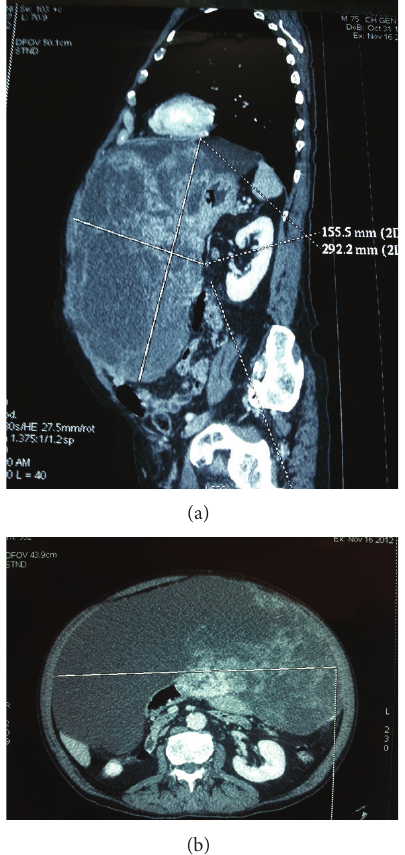
Figure 1: Preoperative contrast-enhanced abdominal CT scan: (a) the sagittal projection shows a large and well-defined, 32 × 29 × 15cm, heterogeneously enhanced mass that displaces and com- presses posteriorly the abdominal organs; (b) the axial projection shows some parts composed of irregular tissue showing enhance- ment; others are hypodense with cystic aspects and contextual septa.